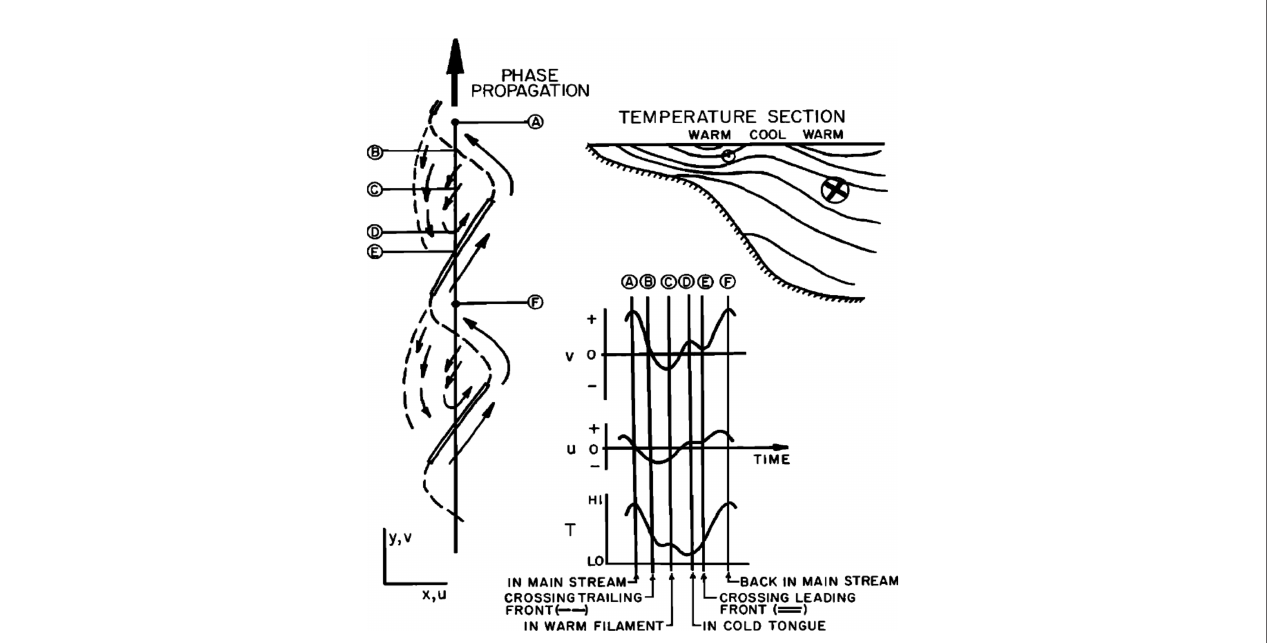
FIGURE 2 | Schematic meander structure and currents based on measurements made at location B1 shown in Figure 1 and reported by Bane et al. (1981). The time series show alongstream (v) and cross-stream (u) velocity components and temperature (T) as a meander passes location